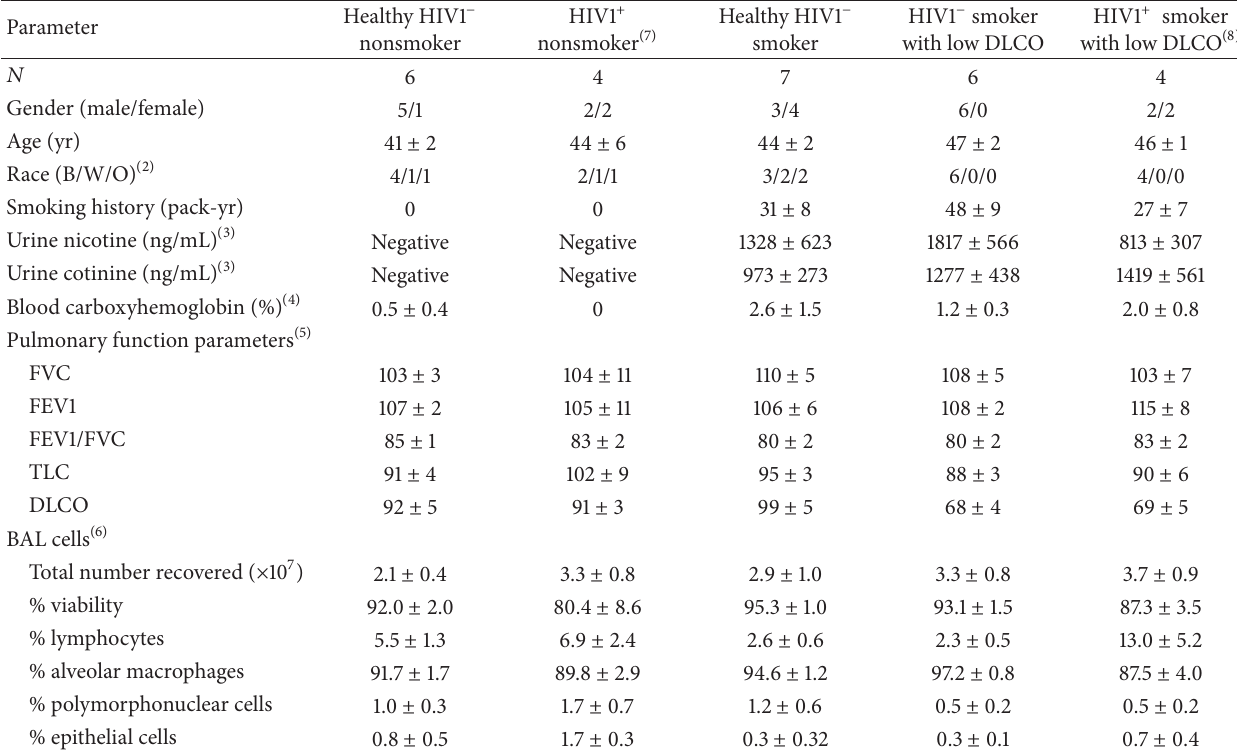
Table 1: Study population and alveolar macrophage samples (1)